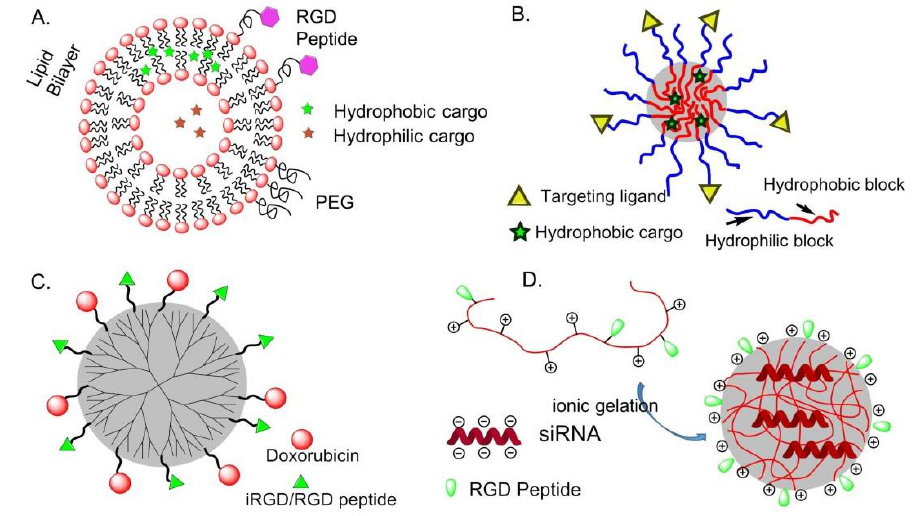
Figure 6. Integrin-targeted organic nanoparticles (NPs). ( A ) liposomes; ( B ) polymeric micelles; ( C ) dendrimers; ( D ) chitosan NPs.